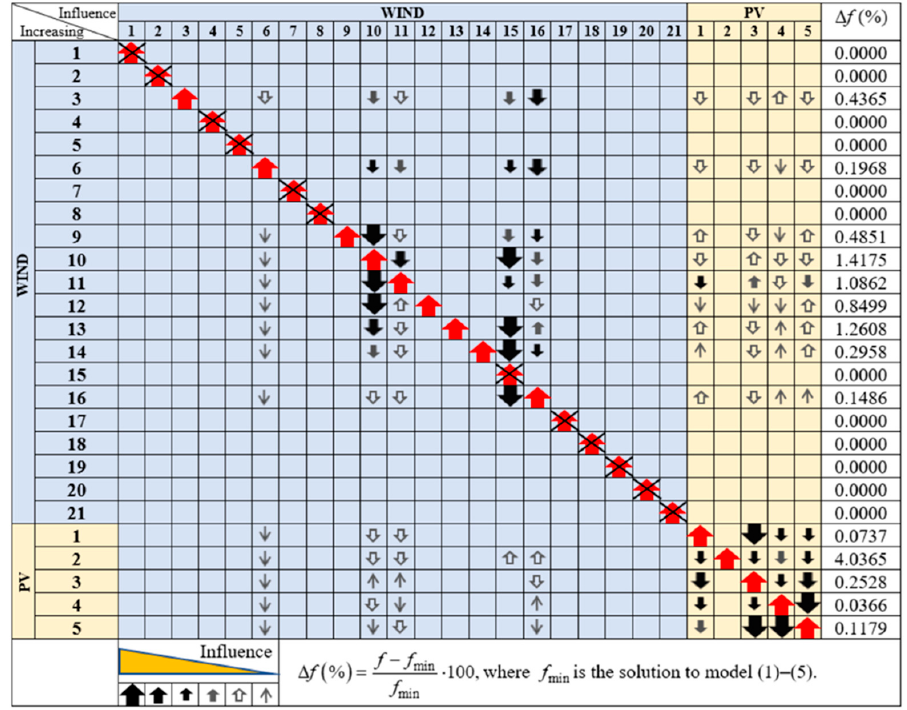
Figure 13. Means to reduce the effect on the sum of squared errors when increasing the capacity in exactly one region.